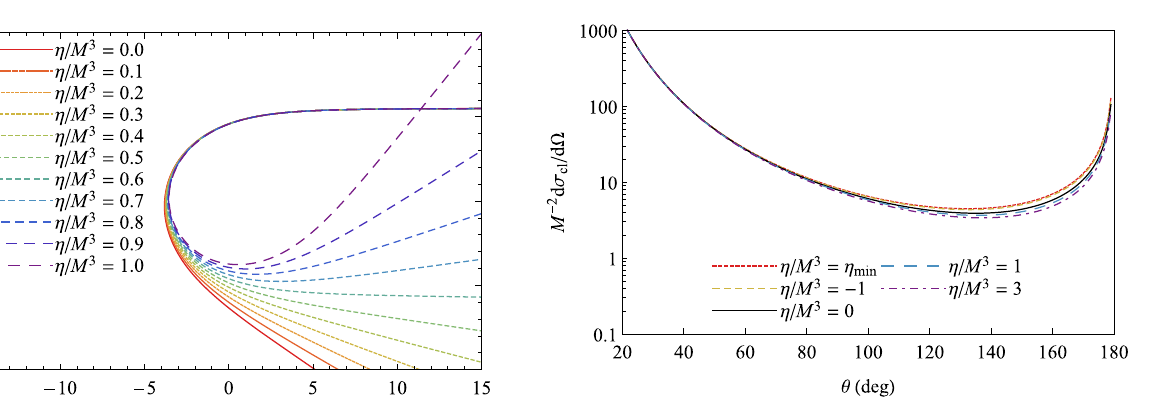
Fig. 3 Comparison between the classical scattering cross section of the parametrized black holes (3), for η/ M 3 = η min , − 1, 1 and 3, with the Schwarzschild case (η/ M 3 = 0